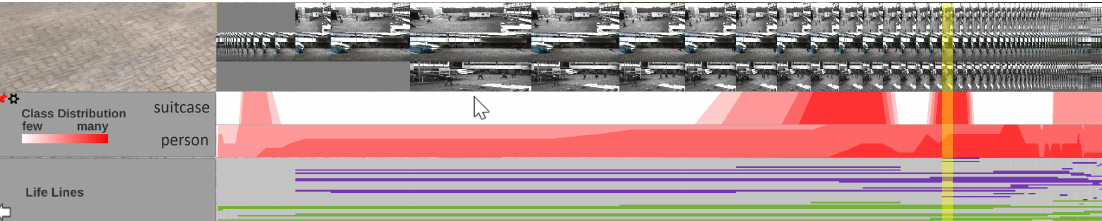
Figure 25. The bottom panel consists of three elements: At the top is a frame preview of all selected cameras. In the center, the class distributions of the detections are visualized as horizon charts. At the bottom is a chart depicting the appearances of all detections as